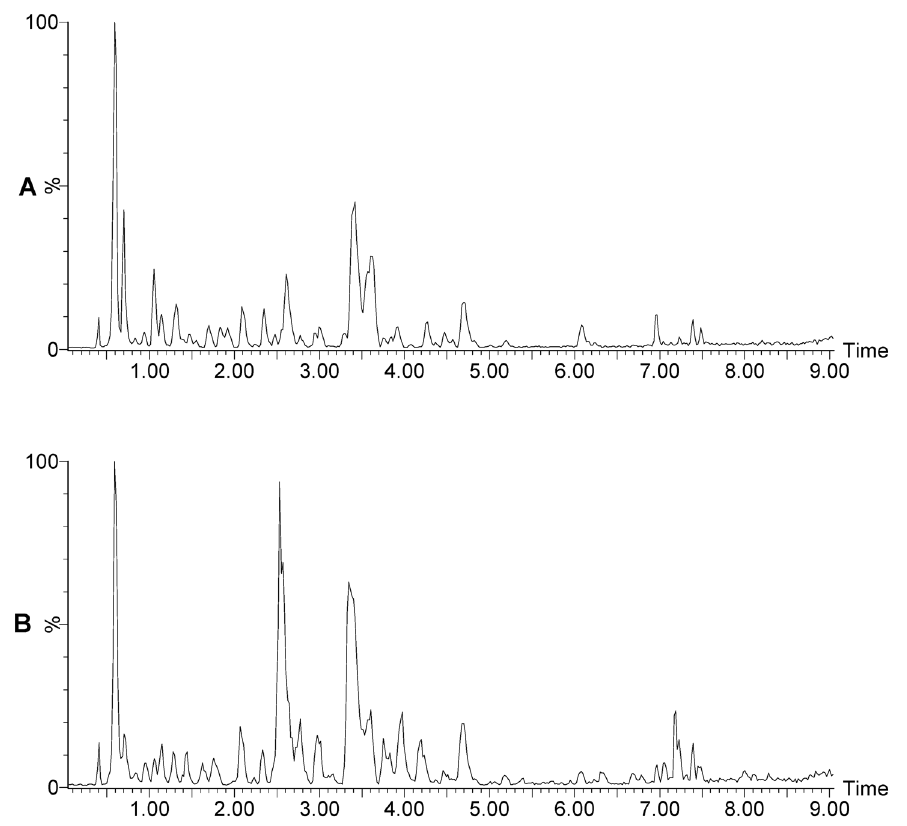
Figure 1. Representative positive base peak intensity (BPI) chromatograms of urine samples at 336 h post-treatment: (A) GF-treated group (B) Healthy control group